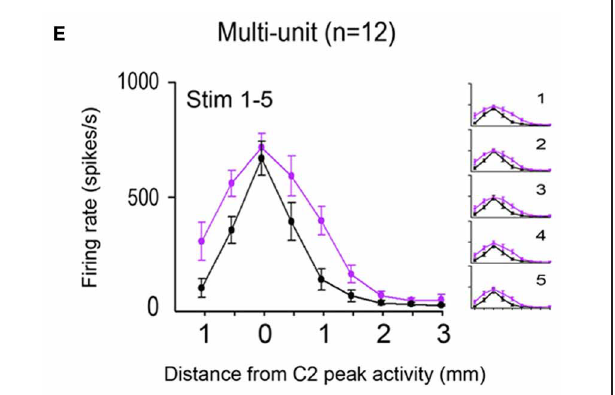
FIGURE 3 | Average in vivo data for the 24-whiskers array. The multi-whisker functional representation (MWFR) for the 24-whiskers array was assessed in vivo using intrinsic signal optical imaging ( n = 10; A–C ) and supra- and sub-threshold neuronal recordings from an 8-electrode array ( n = 12; D,E ). The single whisker functional representation (SWFR) for whisker C2 was also assessed in the same rats for reference. (A–C) The average in vivo -MWFR for the 24-whiskers as assessed with imaging for the same 6 × 6mm field-of-view can be plotted in 2D with barrel cortex topography superimposed (A) or in 3D (B) . It can also be plotted as a line plot for the rostral-caudal slice through the center of whisker C2 barrel and hence through the center of the 24-whiskers’ MWFR and C2 whisker’s SWFR ( C ; mean ± SE as solid line and shading, respectively). Scale bar = 1mm in (A) ; colorscale is the same in (A,B) . ( D,E ) The average in vivo -MWFR as assessed with neuronal recordings. Plotted is the mean ± SE of sub- (D) and supra- (E) threshold neuronal activity of the MWFR for 24-whiskers (magenta trace) vs. the SWFR for whisker C2 (black trace). Whisker stimulation consisted of 5 back-and-forth whisker deflections in the rostral-caudal direction delivered at 5Hz; parent panels contain data averaged across the five stimulus whisker deflections whereas panel insets contain data separated according to stimulus deflection. For both imaging ( A–C) and neuronal recording (D,E) data, note that the MWFR for the 24-whiskers array consists of a single peak located centrally within a large activation spread, thus resembling a relatively symmetrical activity mountain with one peak. Also note that, compared to the single whisker C2, the 24-whiskers’ MWFR exhibited no shift in location of peak activity, no (C,E) or modest (14%; D ) increase in peak magnitude, and relatively moderate increases in the tangential spread of activity and thus a broader shape of the activity